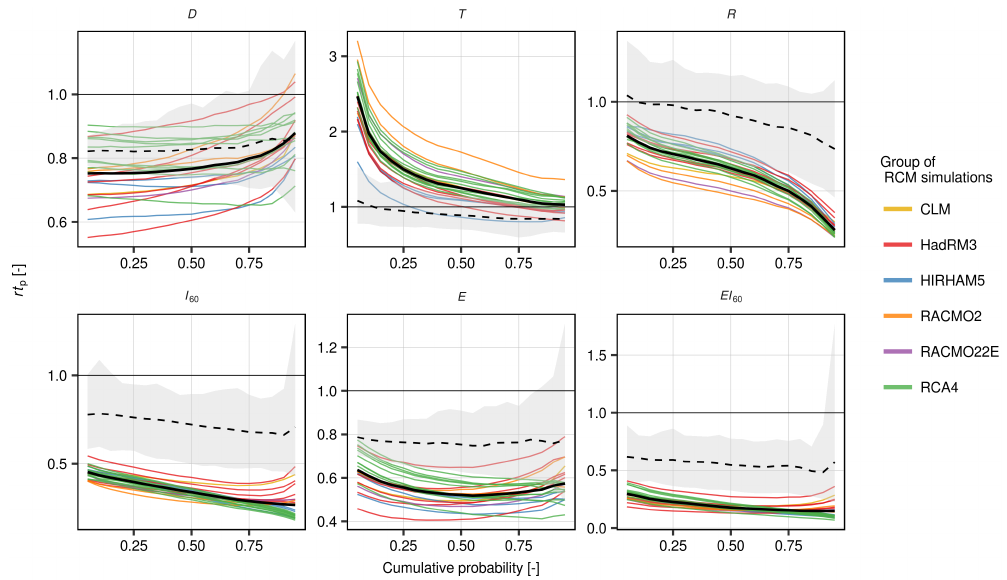
Figure 4. Area-average quantile ratios rt p for the event characteristics derived from RCM simulations. Bold black line shows average from all RCM simulations. Grey area corresponds to the 90% envelope of the quantile ratios for the area-average observations, and broken line indicates the areal average.